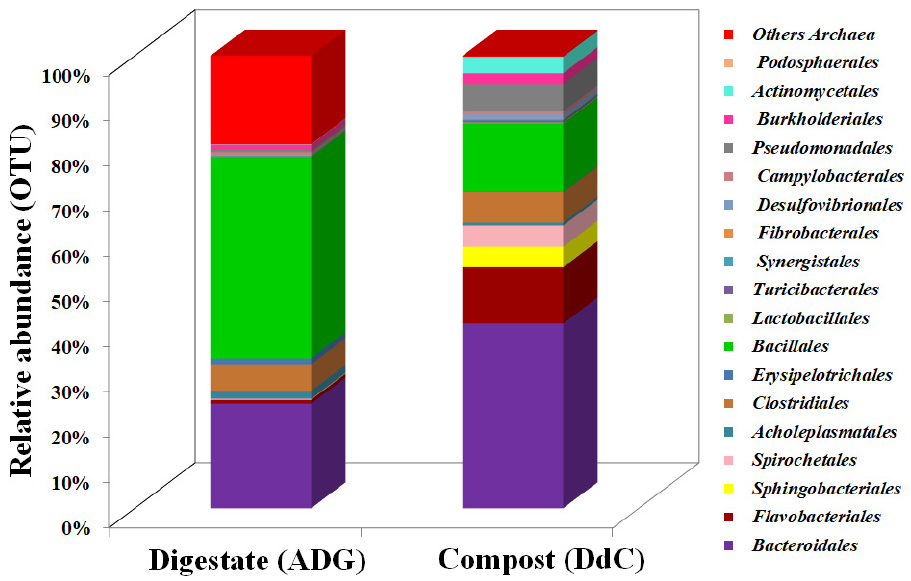
Figure 4. Shared microbiome composition (at order level) of the digestate (ADG) and the digestate-derived compost (DdC). The taxonomic profile is based on the sequencing of the 16S rRNA gene region. Unassigned 16S sequences were excluded.